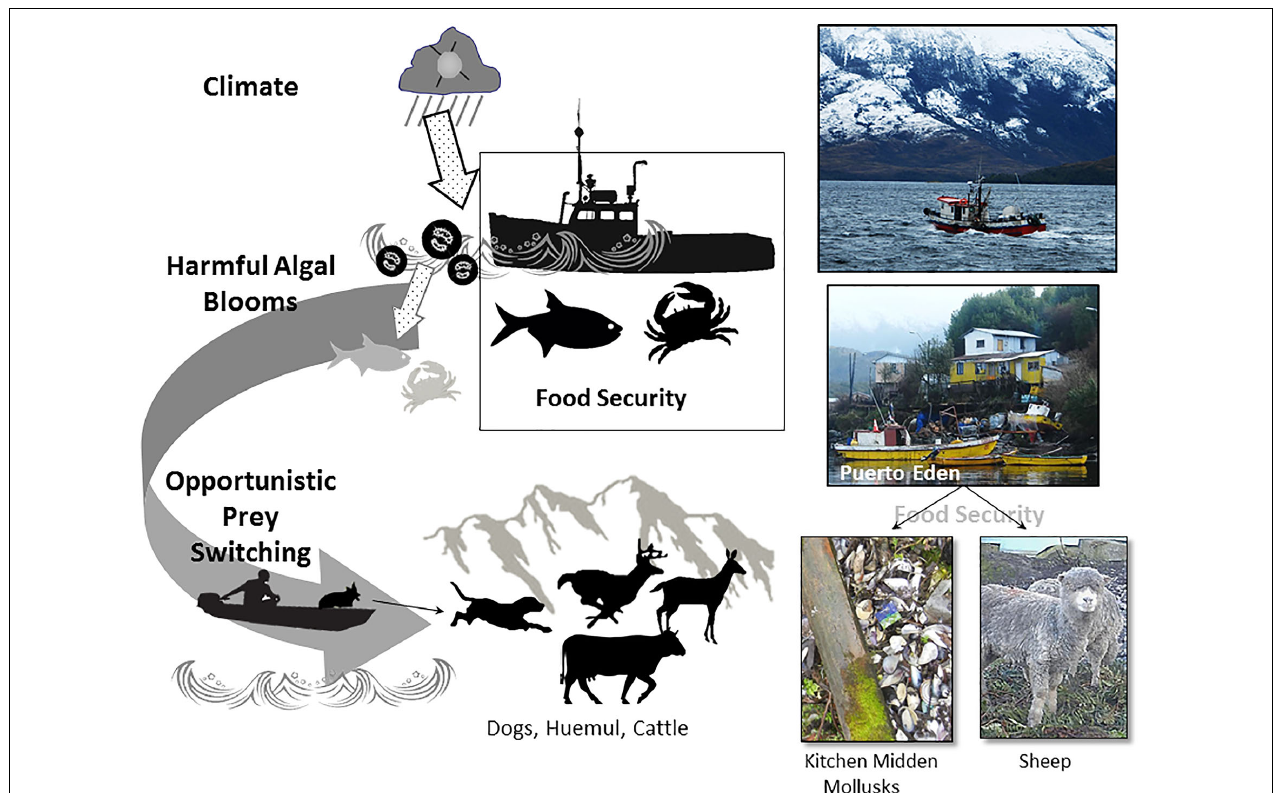
FIGURE 9 | Overview of demonstrated and hypothesized pathways by which climate and harmful algal blooms affect people and possibly huemul. Light gray fish and mollusks reflect higher-than-normal mortality and the testable proposition that HAB leads to elevated onshore foraging options. Fishing vessel (top) 30 km from Puerto Eden, bivalves outside a home, and sheep with thick wool–all photos are from Puerto